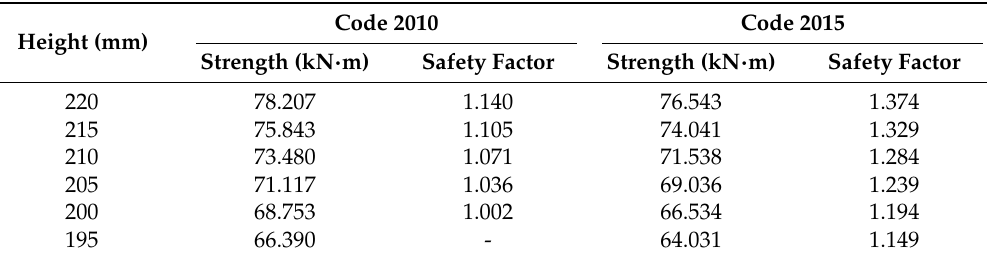
Table 5. Strength based on the change in the height of the cross